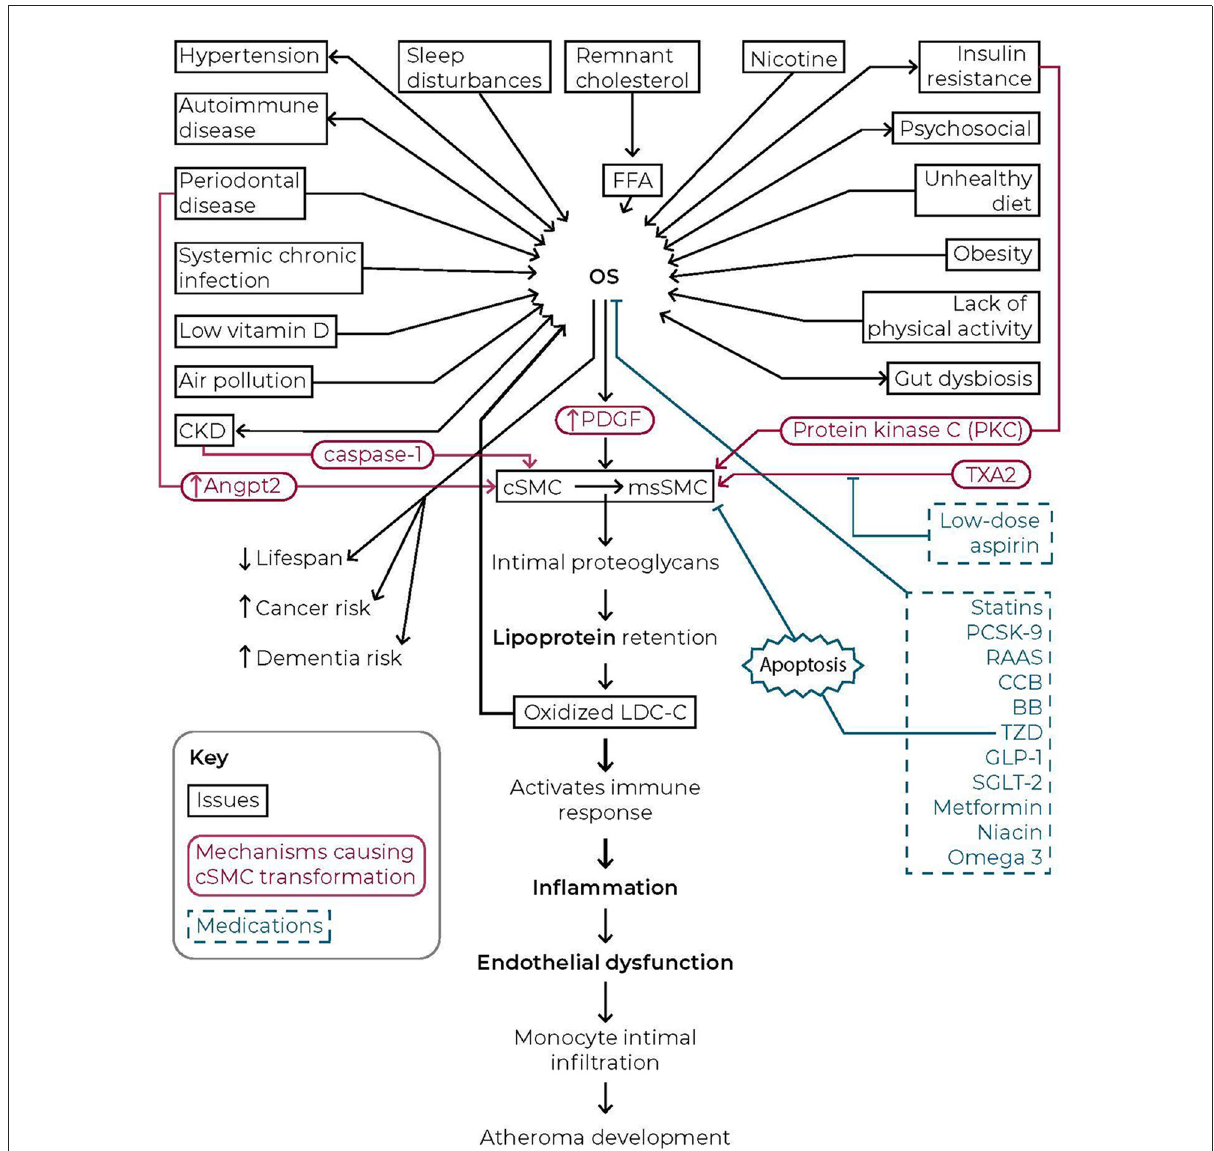
FIGURE1 Comprehensive schematic of the role oxidative stress plays in cardiovascular disease. The multiplicity of risk factors for cardiovascular disease that drive oxidative stress which in turn results in a well-defined cascade of events that drive the development of atheroma in the vessel is presented. These cellular events lead to a decrease in lifespan and an increase in dementia and cancer risk. The linkage between lipids and inflammation is a critical consideration in the management of cardiovascular disease. Reduction in critical risk factors and the judicious use of medications (blue) can reduce levels of oxidative stress and in turn halt the progression of events leading to the development of